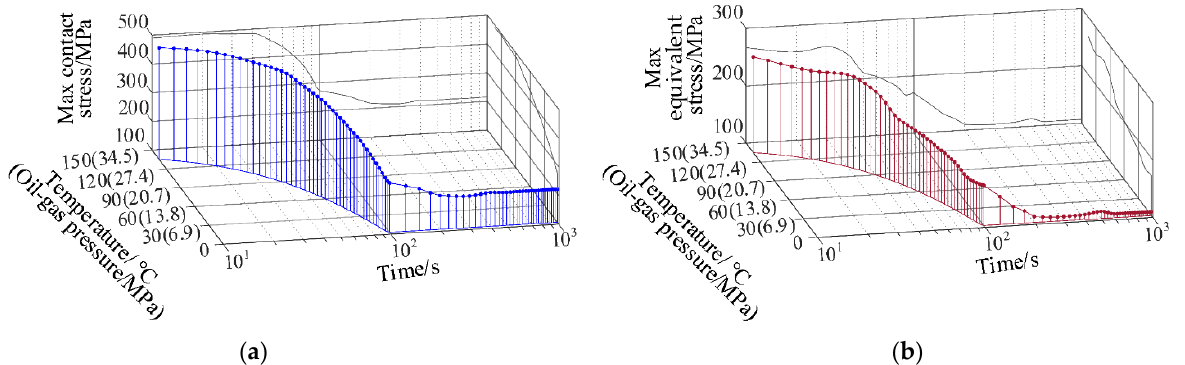
Figure 7. Variations of maximum contact stress and maximum equivalent stress of the LSG under the working condition of temperature–pressure drop. ( a ) Maximum contact stress; ( b ) maximum equivalent